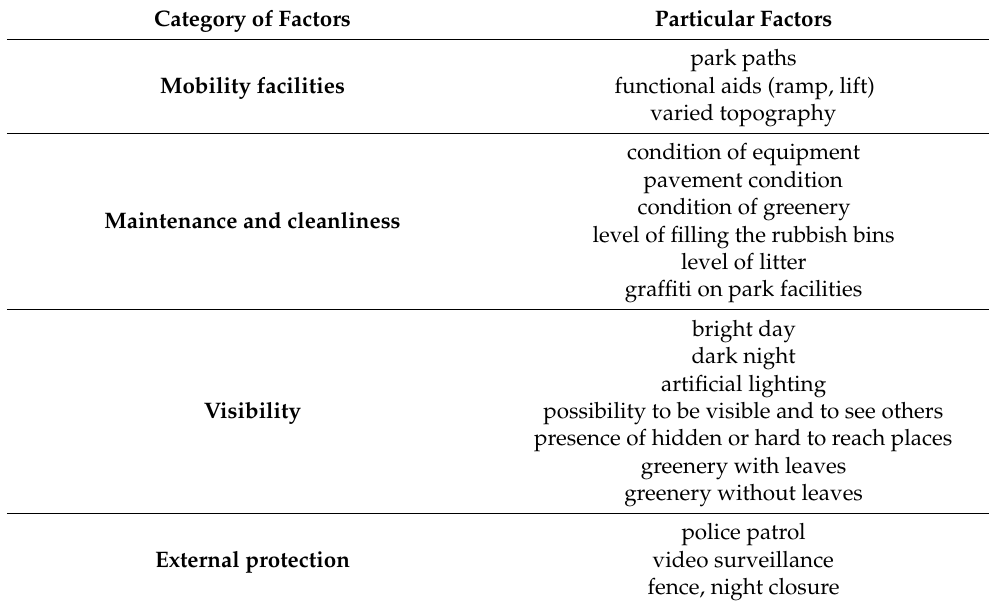
Table 2. Categories of factors indicated in questionnaire (elaborated by